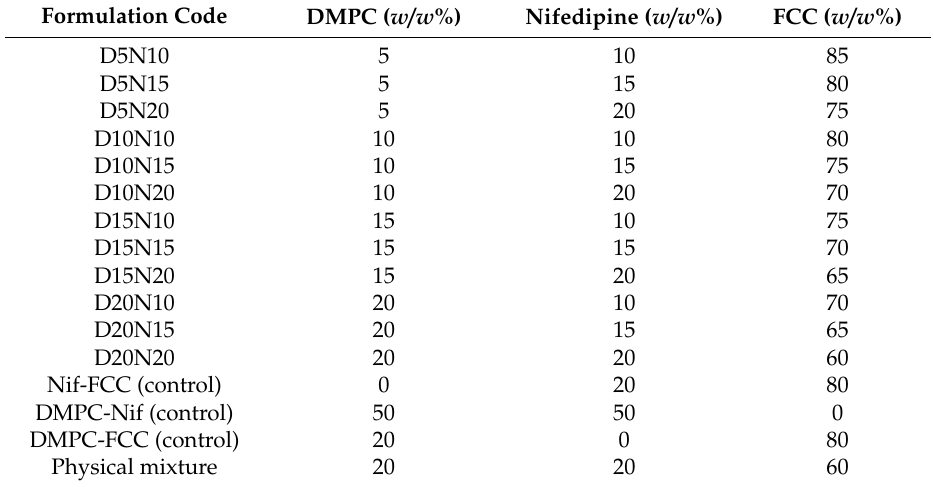
Table 1. Expected drug and lipid composition of the sample